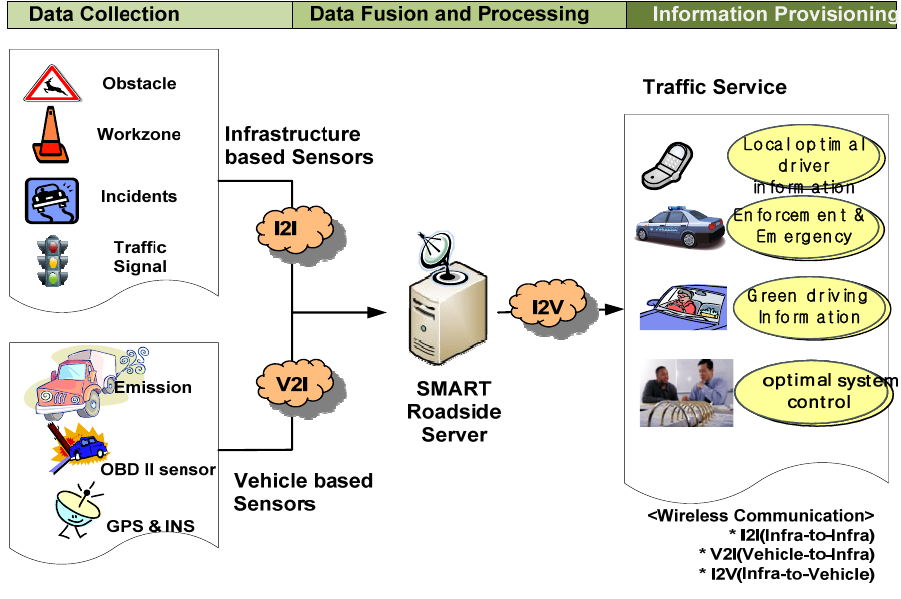
Figure 4. Framework of smart road server and sensor system.